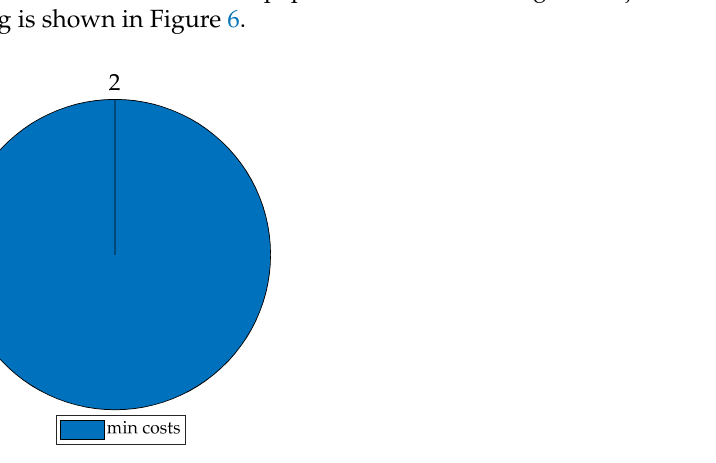
Figure 6. Number of selected papers associated with a given objective for dynamic programming.